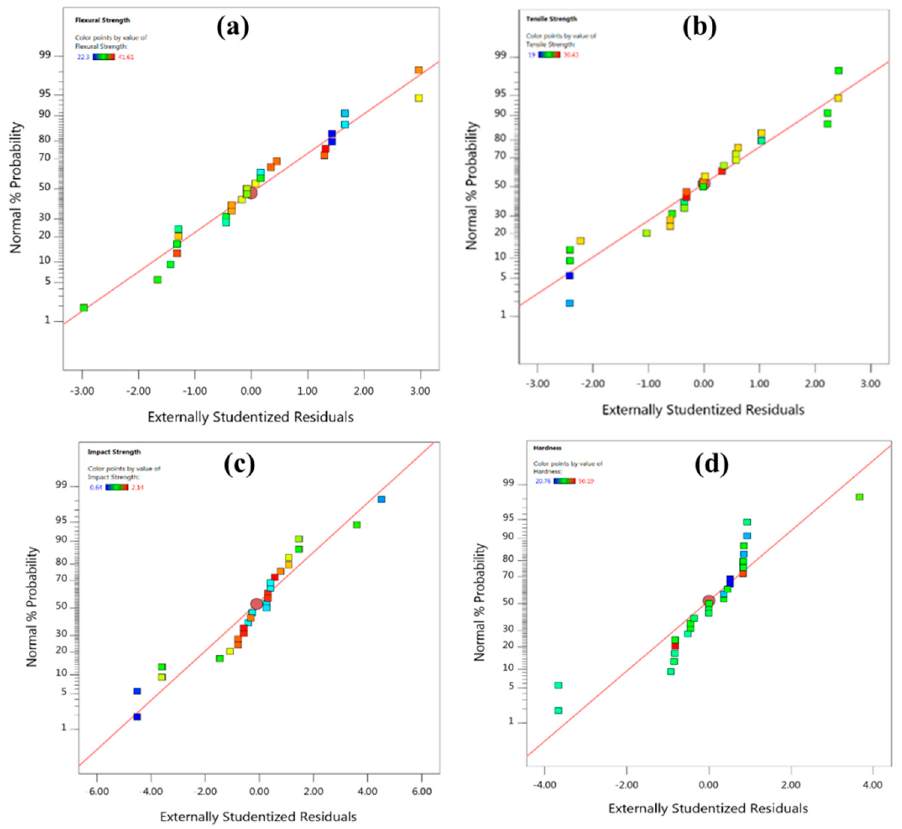
Figure 4. Normal probability plots for ( a ) flexural strength ( b ) tensile strength, ( c ) impact strength and ( d ) hardness. and ( d )